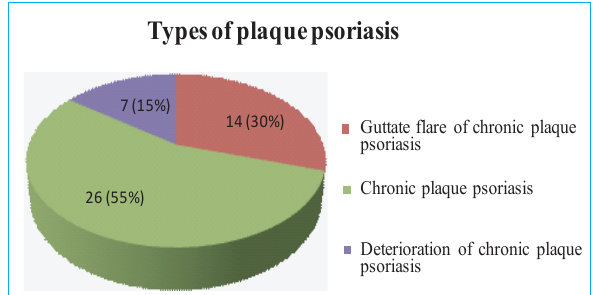
Table III: Level of ASO titer in different types of plaque